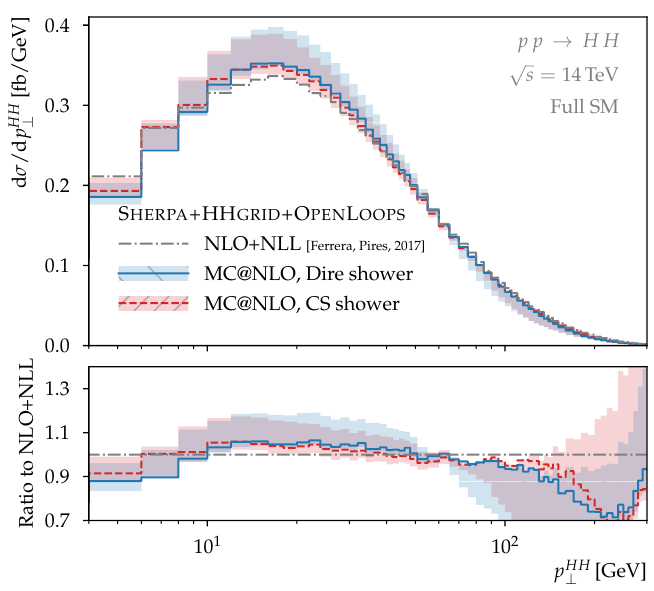
Figure 8 . Comparison with results of the analytic resummation calculation of reference [16]. Uncertainties on the NLO parton shower matched results were obtained by varying (cid:22) PS